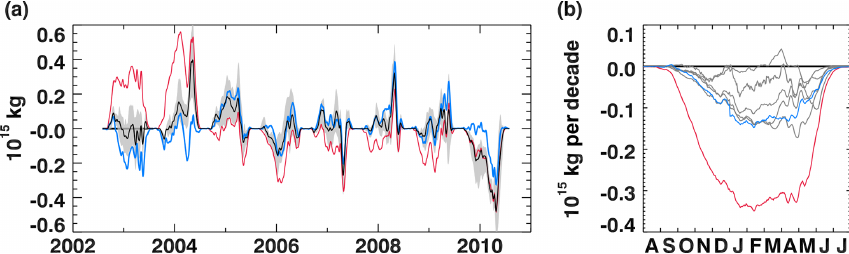
Figure 7. (a) Average Northern Hemisphere snow mass anomalies (black) and spread (shading) calculated from five component products: MERRA-2, Crocus, GlobSnow v2.0, GLDAS-2, and ERA-Interim/Land along with snow mass anomalies from raw (red) and corrected (blue) ERA5 values. (b) Trends (1981–2010) from the five component time series used for the average in panel (a) (grey) along with trends from the raw (red) and corrected (blue) ERA5 time series. The ERA5 discontinuity occurs in January 2004.